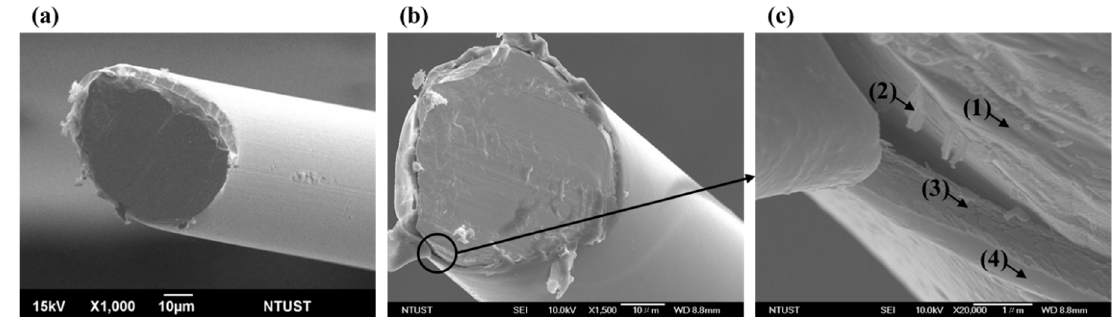
Figure 2. The cross-sectional structure of ( a ) the bare Pt wire electrode (×1000); ( b ) the ALT biosensor ( ˆ 1500); and ( c ) the ALT biosensor ( ˆ 20,000); layer ( 1 ): Bare Pt wire; layer ( 2 ): Overoxidased